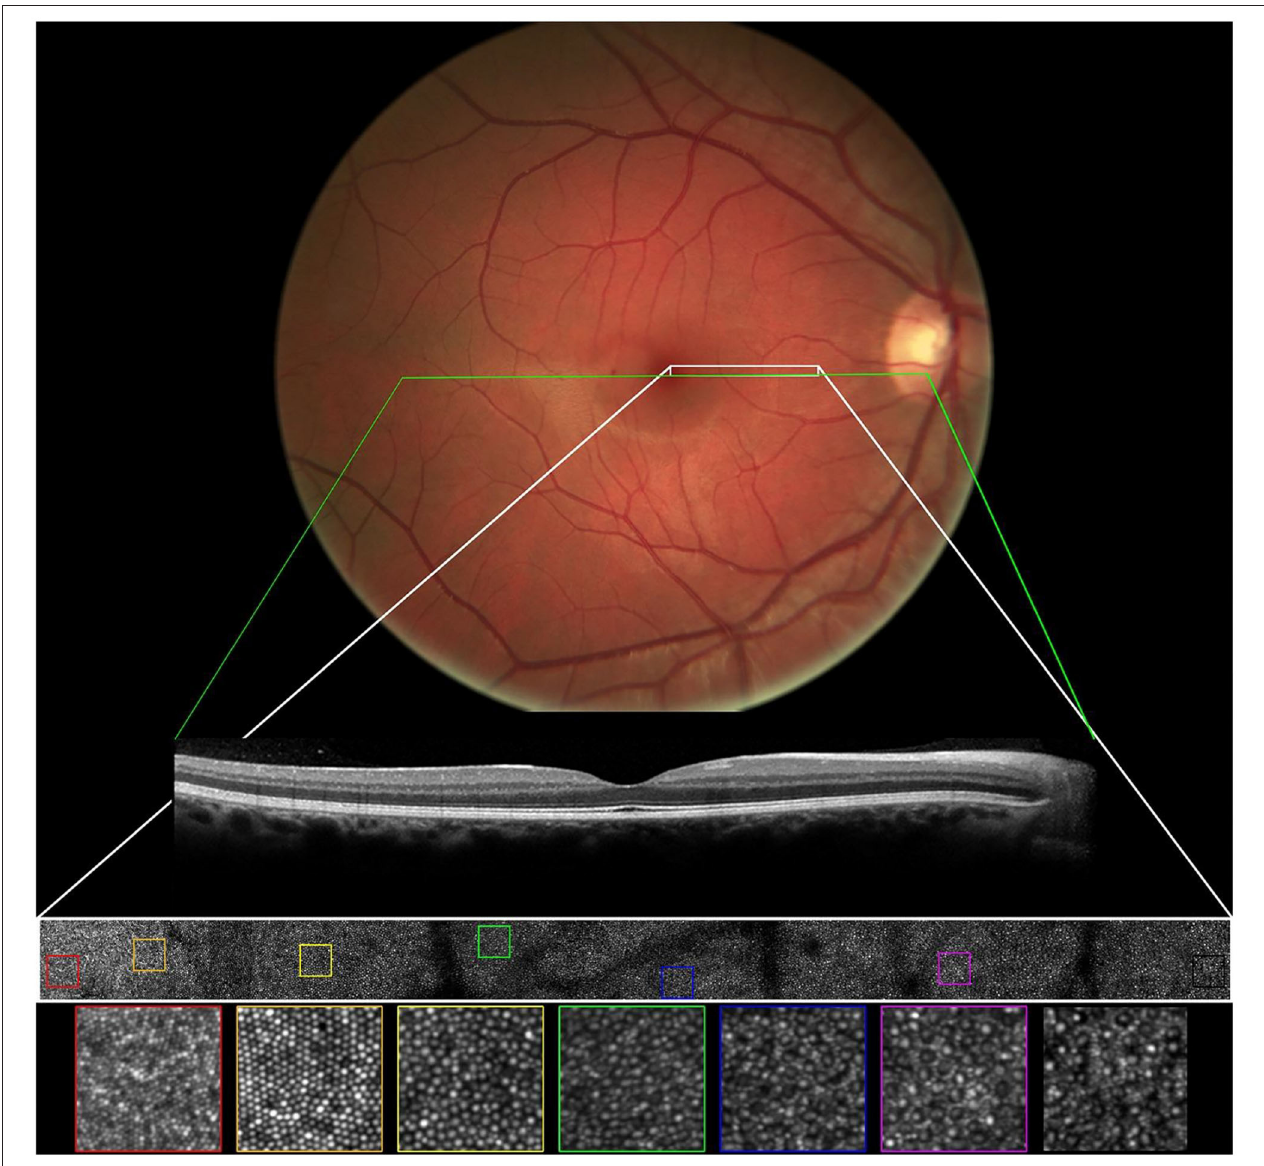
FIGURE 2 | Comparison of a conventional fundus photograph. SD-OCT cross sectional image obtained (green line) was overlaid on the fundus photograph and a montage of confocal AO-SLO images acquired (white box) was overlaid on the fundus image in the right eye of a 31 year old normal male. Magnified photoreceptor mosaic images from AO-SLO montage has been represented in colored boxes. This images has been adapted from [33] with